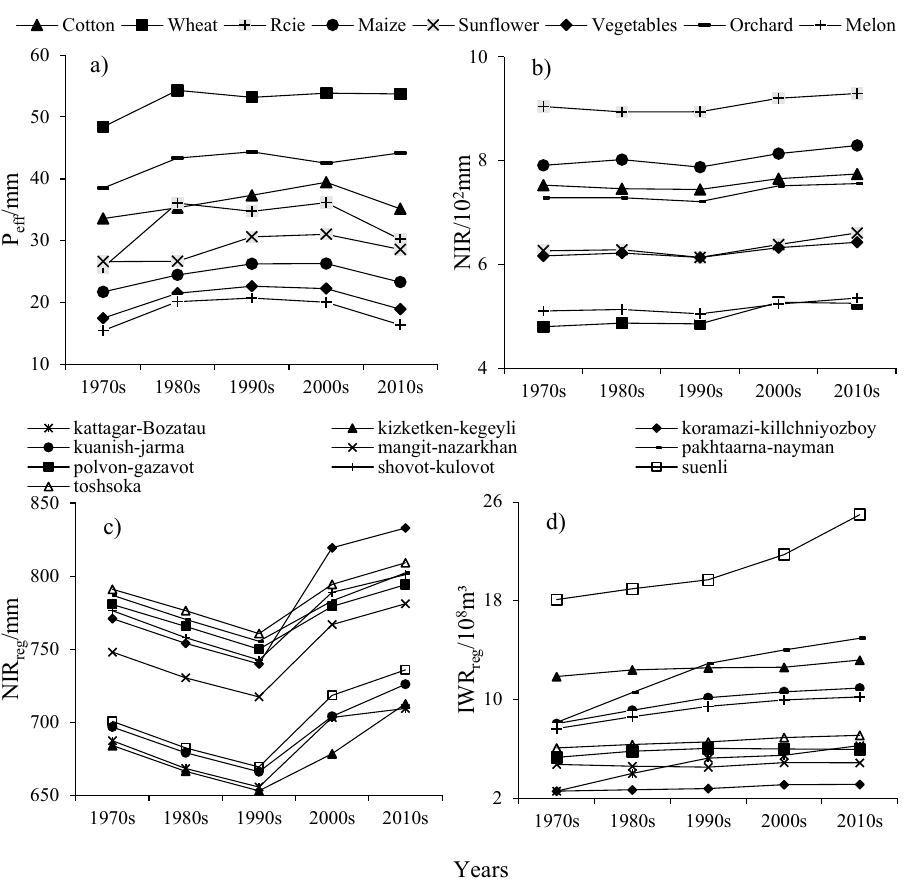
Figure 6. Variations of Peff ( a ) and NIR ( b ) for different crop types; NIRreg ( c ) and IWRreg ( d ) in the UISs during the 1970s to the 2010s. Notes: 𝑃 (cid:3032)(cid:3033)(cid:3033) , the effective precipitation; 𝑁𝐼𝑅 , net irrigation requirement; 𝑁𝐼𝑅 (cid:3045)(cid:3032)(cid:3034) , regional net irrigation requirement; 𝐼𝑊𝑅 (cid:3045)(cid:3032)(cid:3034) , regional irrigation water re-